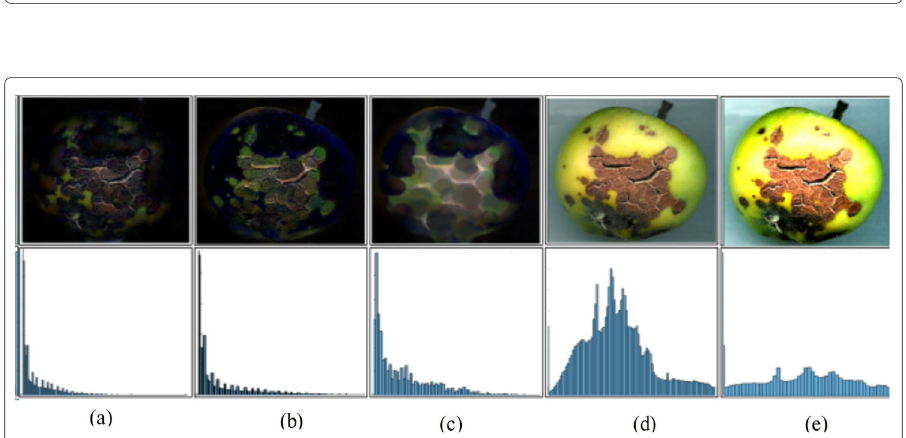
Fig. 3 Proposed contrast stretching results. a Initial global minimum value image. b New global minimum pixel image. c Contrast range image. d Variation removal image. e Final enhanced